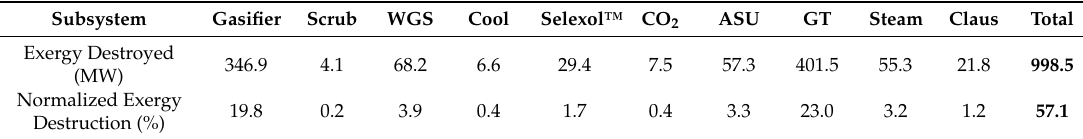
Table 6. Baseline Model Results, assigning exergy destruction associated with heat transfer to/from the Steam subsystem to the non-Steam